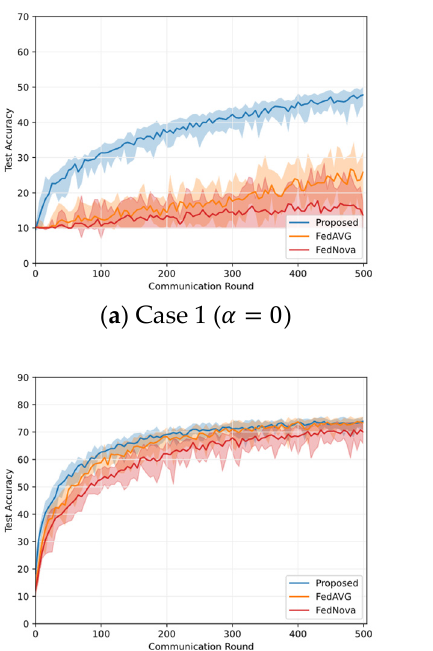
10 of 16 Table 2. Distribution setup and experiment parameters. Distribution Setup Experiment Parameter Datasets